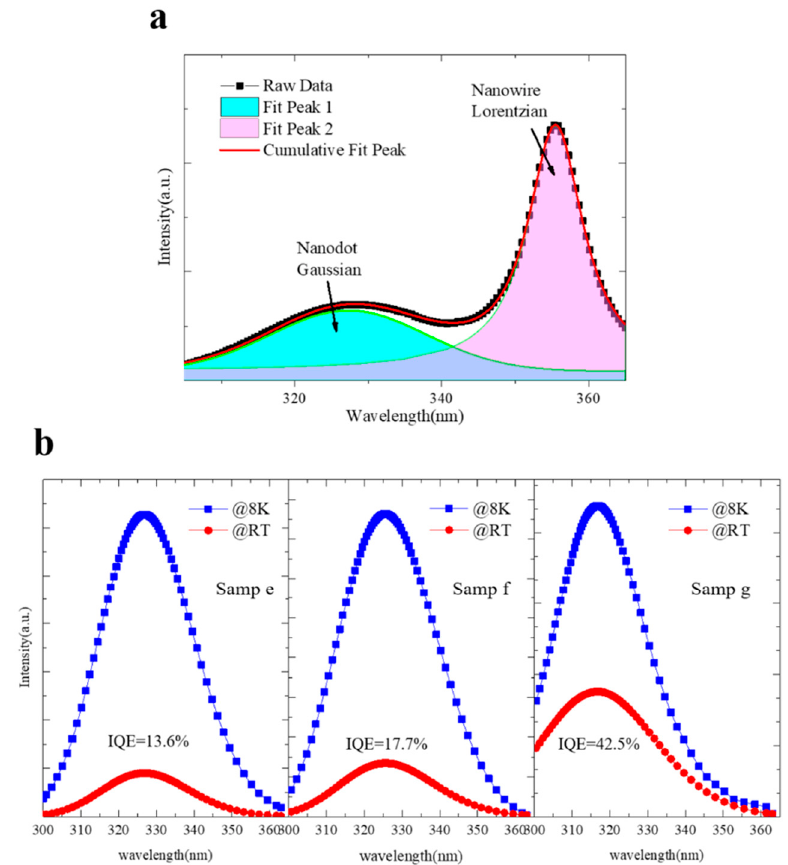
Figure 5. PL results of various samples. ( a ) Typical fitted result of room temperature (RT) PL emissions of sample e. The blue and pink enclosed regions represent the emission of quantum dots and nanowires, respectively. ( b ) Low temperature (8 K) and room temperature PL spectra of GaN/AlN quantum dots in nanowires obtained by Gaussian fit.